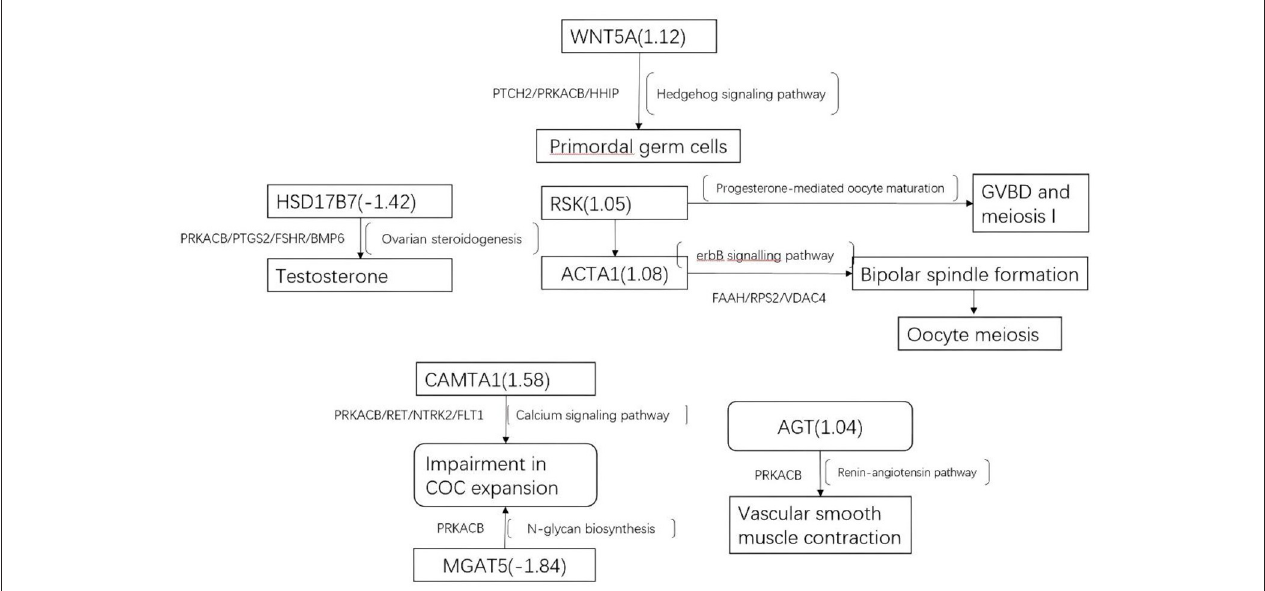
FIGURE 4 | Altered gene methylation and expression and the associated pathways. The figure summarizes some of the processes that could be dysregulated in the follicular compartment, including altered methylation (squares) and expression of genes in cumulus GCs. Differentially methylated genes: ACTA1, AGT, calmodulin-binding transcription activator 1 (CAMTA1), COC, germinal vesicle breakdown (GVBD), HSD17B7, MGAT5, RSK, and WNT5A. Differentially expressed genes: protein kinase cAMP-activated catalytic subunit beta (PRKACB), prostaglandin-endoperoxide synthase 2 (PTGS2), follicle-stimulating hormone receptor (FSHR), BMP6, patched 2 (PTCH2), Hedgehog-interacting protein (HHIP), integrin subunit beta 8 (ITGB8), integrin subunit alpha L (ITGAL), G protein subunit alpha 13 (GNA13), Rho guanine nucleotide exchange factor 4 (ARHGEF4), ret proto-oncogene (RET), neurotrophic receptor tyrosine kinase 2 (NTRK2), and fms-related receptor tyrosine kinase 1 (FLT1) .